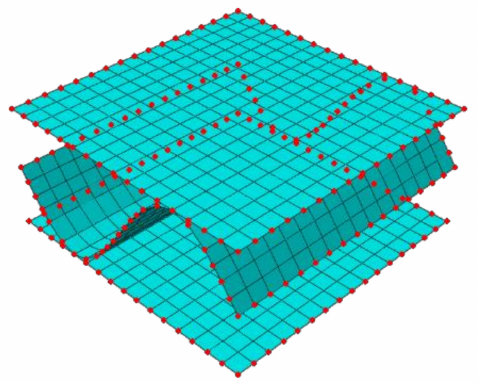
Figure 3. External (in red color) and internal nodes of